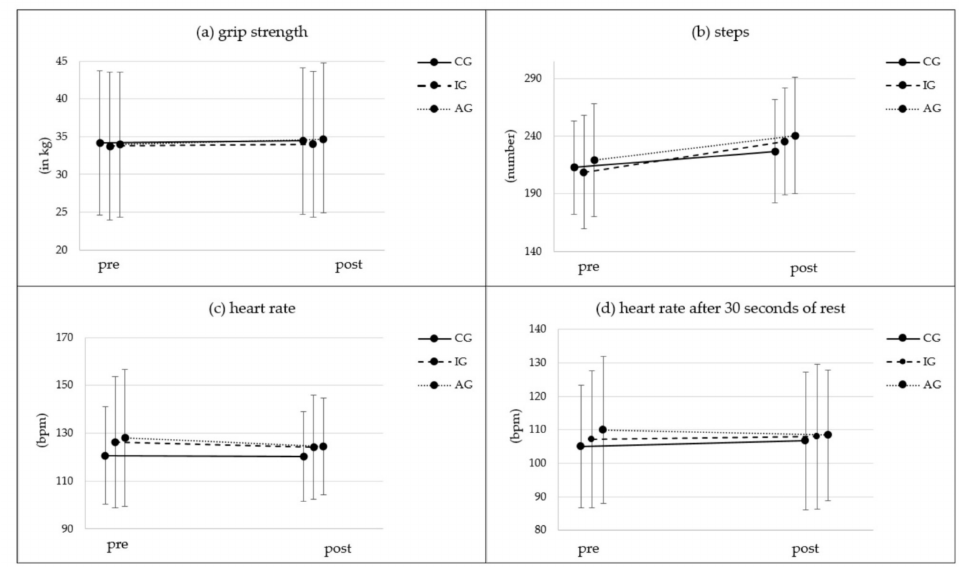
Figure 2. Pre- and post-test results of ( a ) grip strength (kg), ( b ) number of steps per two minutes, ( c ) heart rate (HR) (beats per minute (bpm)) after the two-minute step test and ( d ) HR 30 seconds after two-minute step test (bpm). CG = control group; IG = intervention group without activity tracker; AG = activity tracker group receiving the same web-based intervention as the IG.